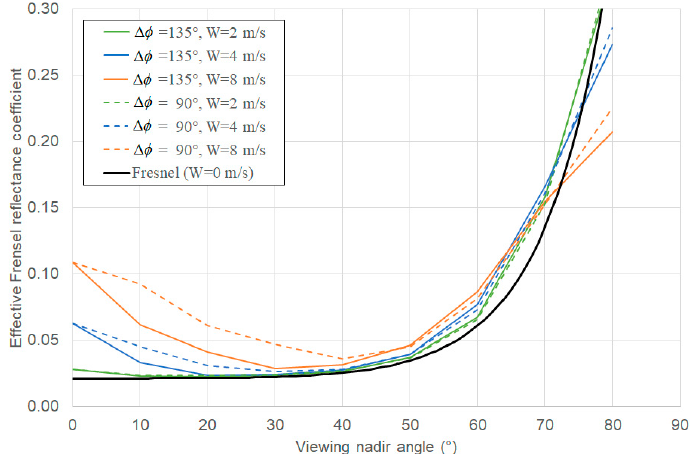
Figure 6. Effective Fresnel reflectance coefficient, 𝜌 (cid:3007) , as function of viewing nadir angle , 𝜃 (cid:3049) , for the flat water case (Fresnel reflectance given by Equation (13)) and for a wind-roughened surface, modelled [75] at 10 ◦ intervals for λ = 550 nm, θ 0 = 30 ◦ , and various wind speeds, W , for L r with relative viewing azimuth angles, ∆ ϕ v .